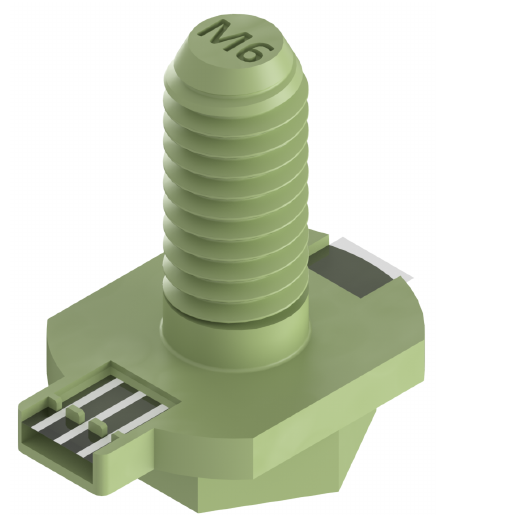
Figure 4. 3-D CAD model of an M6 screw with hexagon head, spacer disk, and contact pad opening for sensor foil integration. The substrate foil and contact pads of the integrated sensor are